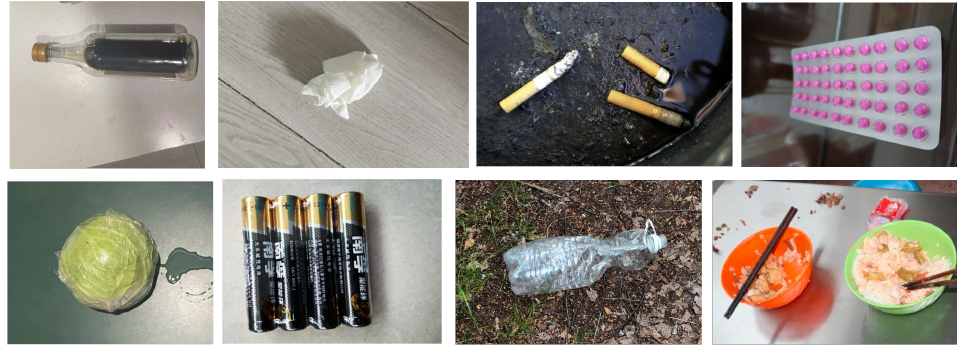
Figure 1. Sample self-built garbage dataset.